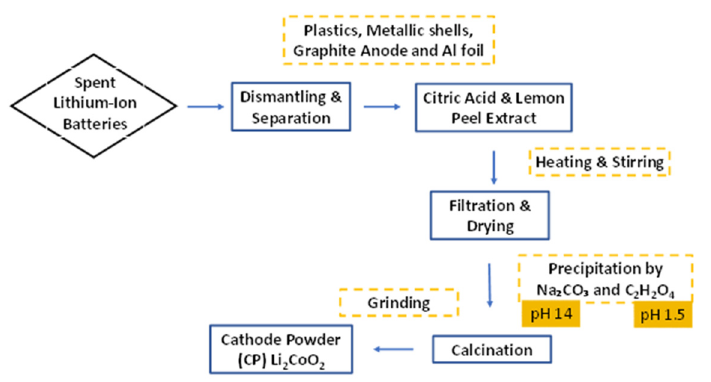
Figure 1. Schematic diagram for the leaching and recycling of an LIB cathode.